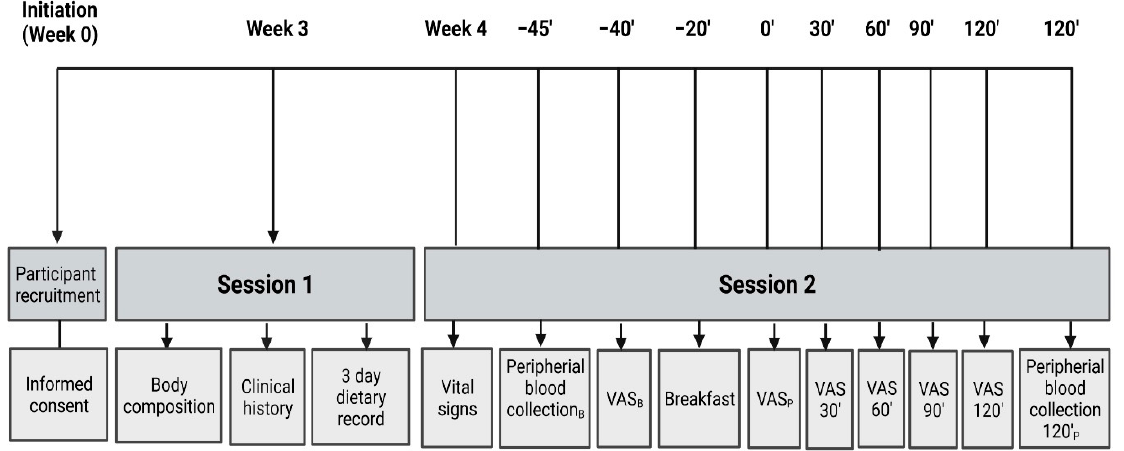
Figure 2. Schematic representation of the study procedure. VAS: Visual Analogue Scales; B: basal; P: postprandial.